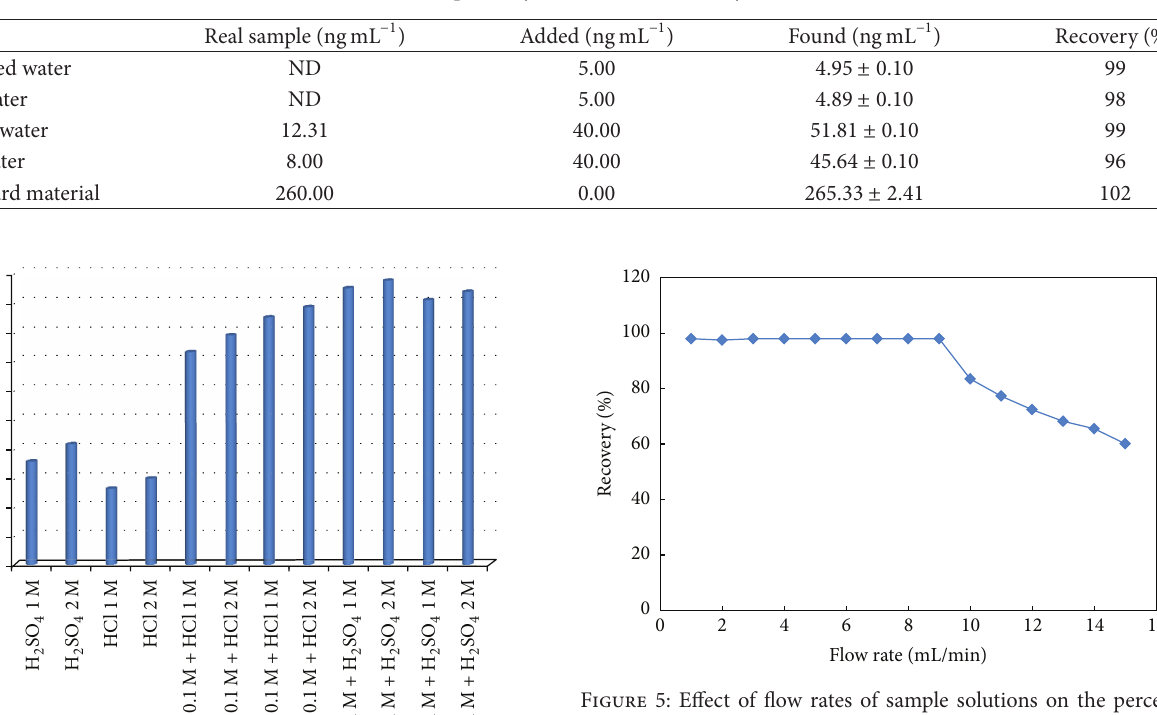
T 2: Data of real sample analysis for Au on 9-acridinylamine alumina.